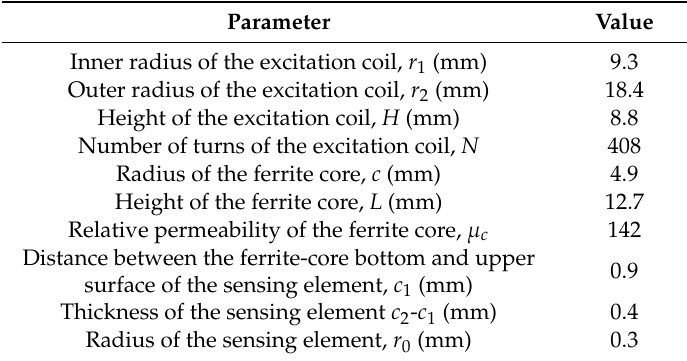
Table 1. Parameters of the PMEC